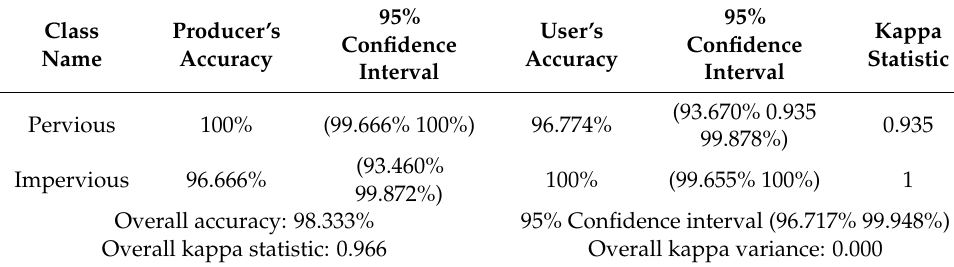
Table 5. 2014 Accuracy statistics report of 300 sampling objects.